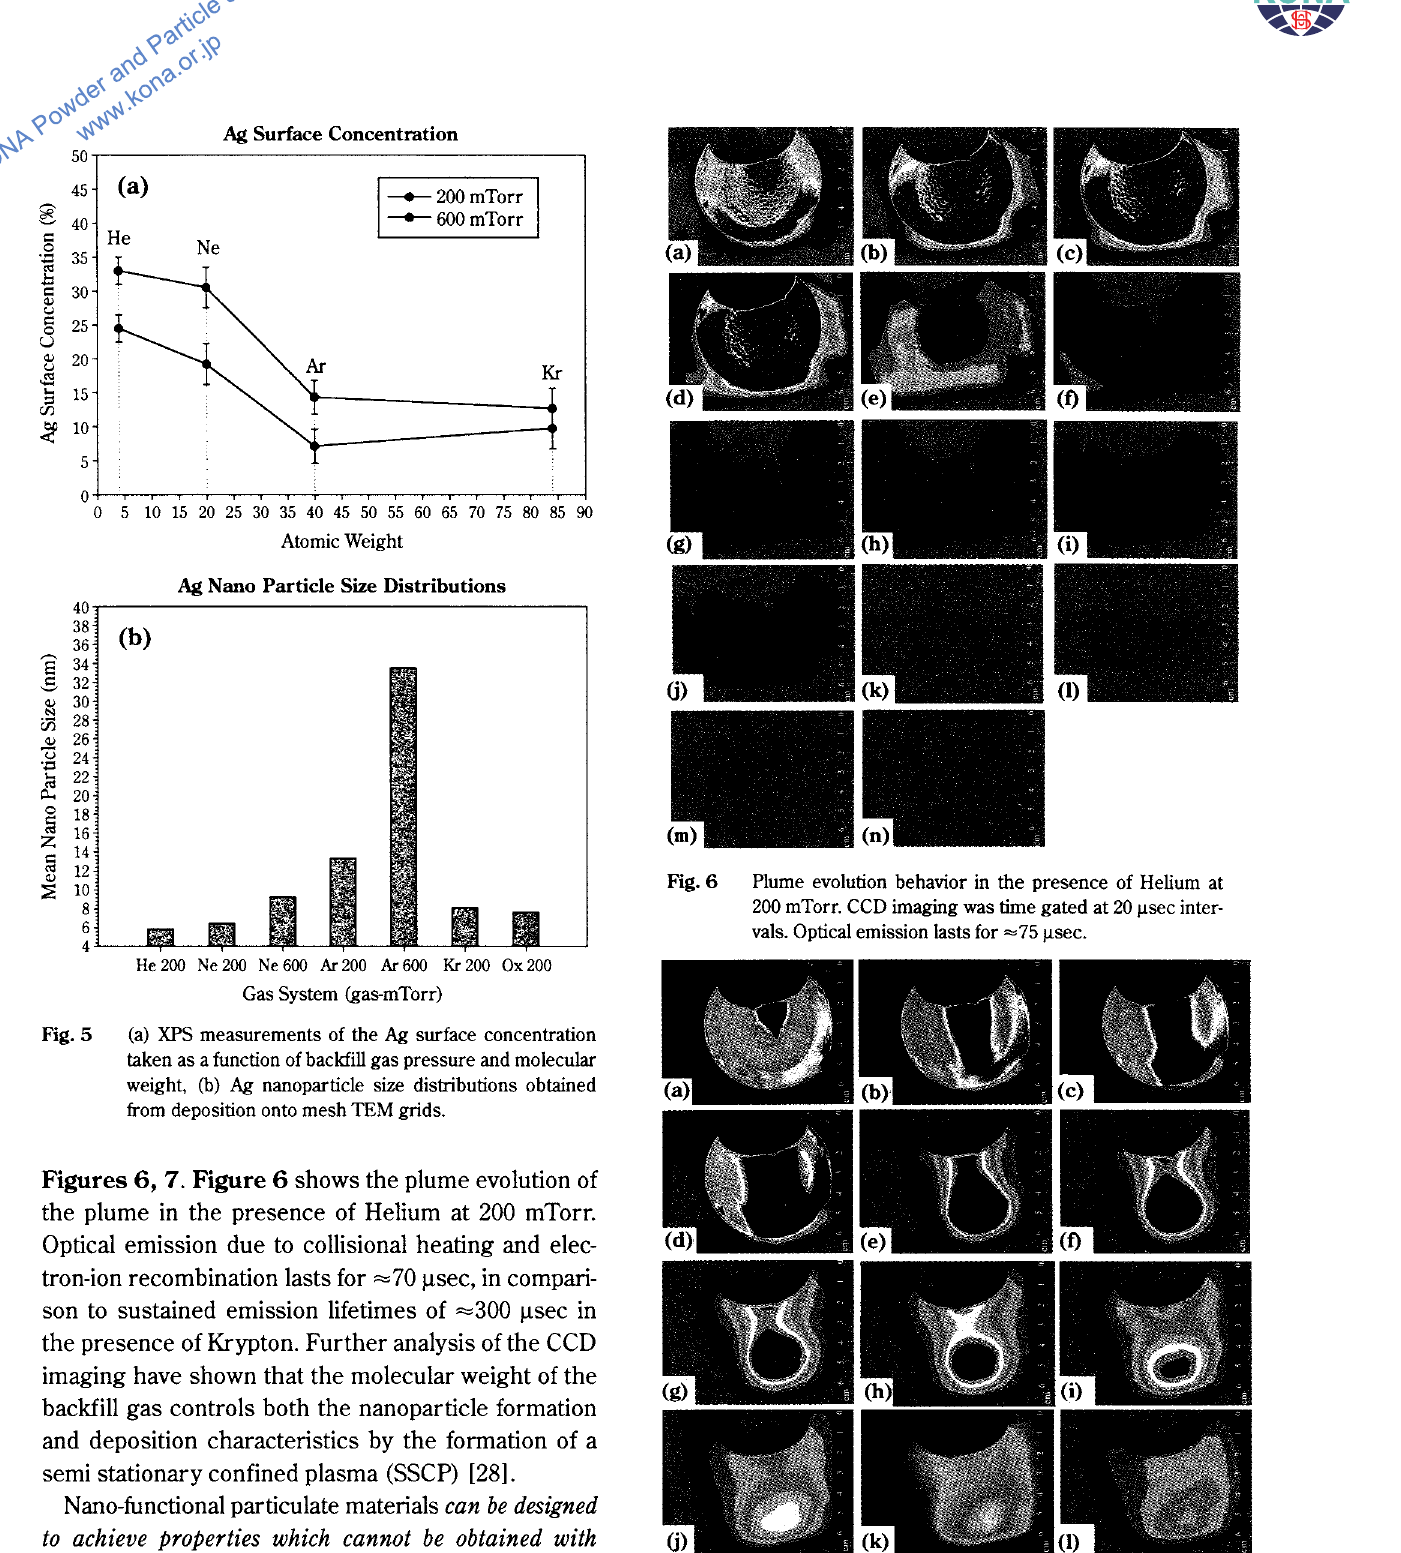
Fig. 7 Plume evolution behavior in the presence of Krypton at 200 mTorr. CCD imaging was time gated at 20 )..lSec inter vals. Optical emission is sustained out to ""300 )..lSec, with confinement of the ablated